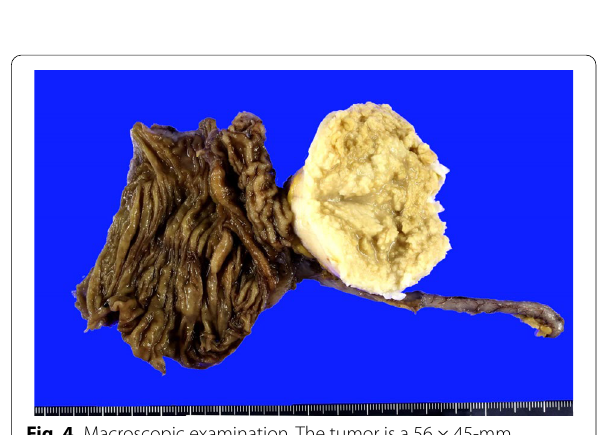
Fig. 4 Macroscopic examination. The tumor is a 56 elastic-hard, whitish, round mass arising from the cecal wall